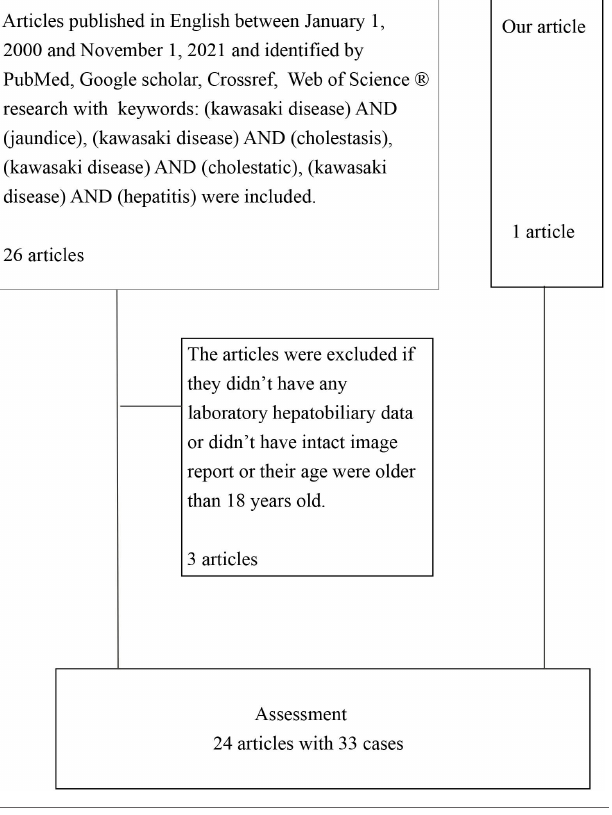
TABLE 1 | Flowchart diagram of data